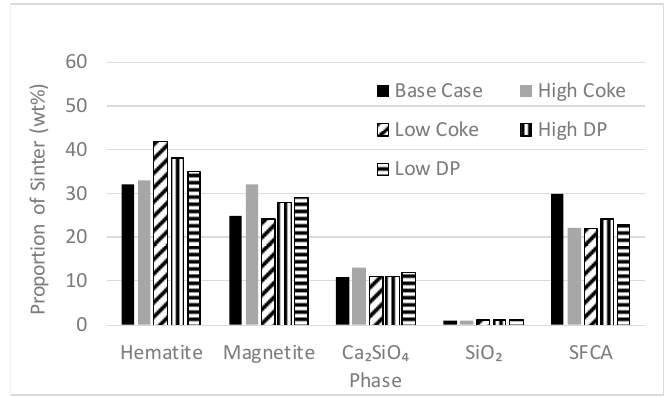
Figure 6. Proportions of phases in the sinter product as determined by semi-quantitative X-Ray Diffraction (XRD).